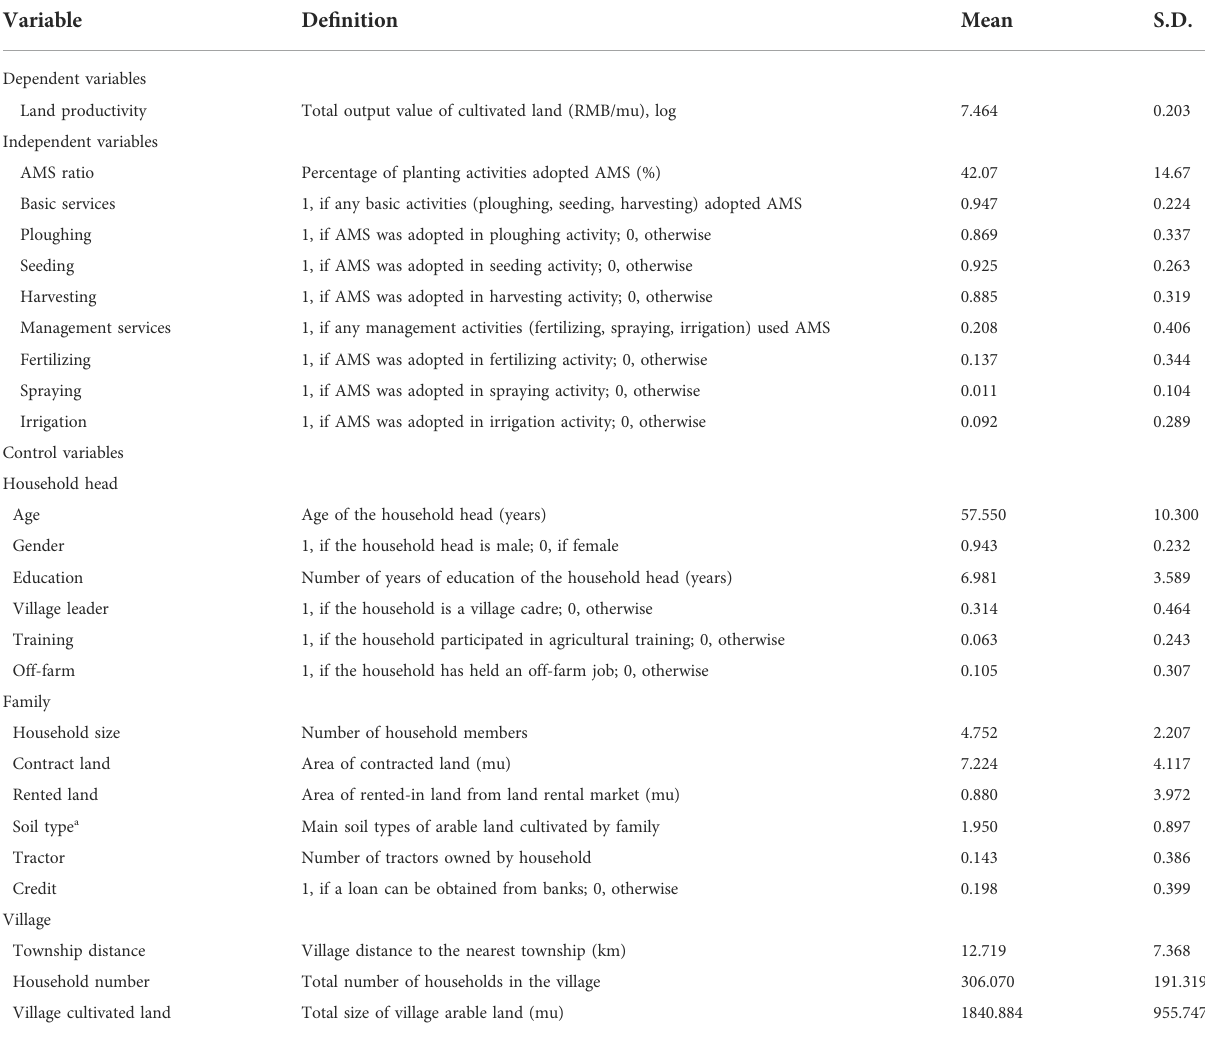
TABLE 1 Variable de fi nitions and summary